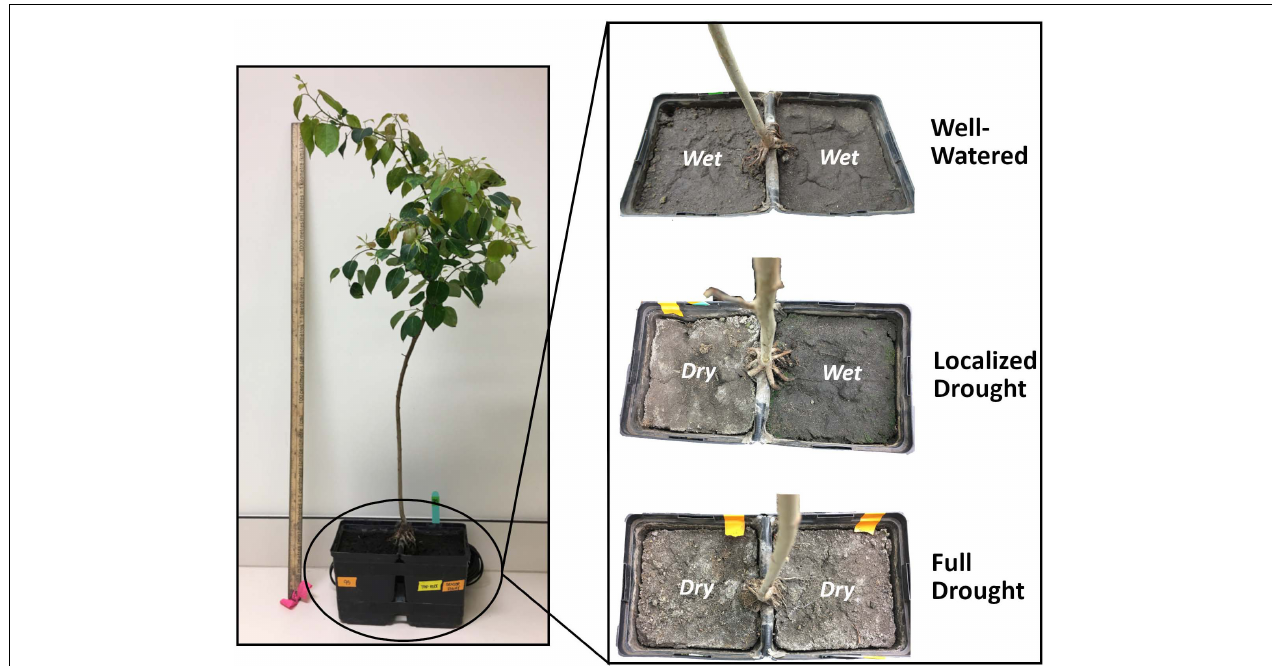
FIGURE 1 | Aspen sapling grown with spatially separated root system using a split-pot design. Aspen saplings were subjected to one of three watering treatments [well-watered (WW), localized drought (LD) or full drought (FD)] characterized by differences in soil moisture